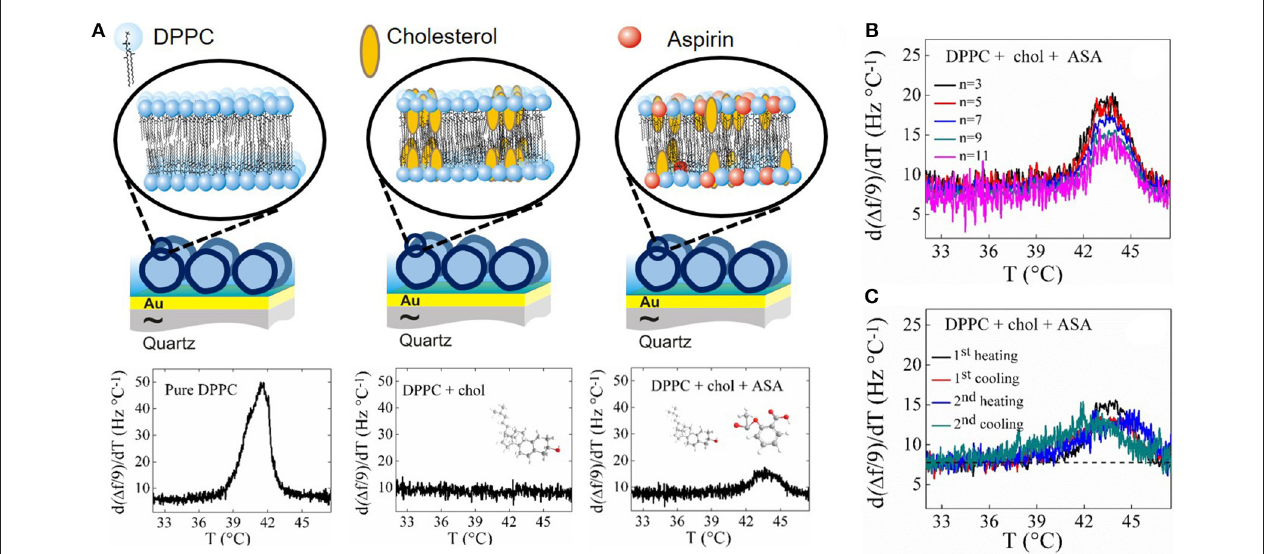
FIGURE 2 | (A) Schematic of a SVL (not to scale) on a Au-coated quartz crystal including the temperature profiles upon the first heating run of d ( 1 f /9)/ dT and d 1 D / dT for SVLs of pure DPPC, DPPC + 32.5% cholesterol and DPPC + 32.5% cholesterol with 6mM aspirin. (B) Overtone dependence of d ( 1 f /n)/ dT for DPPC + 32.5% cholesterol with 6mM aspirin SVL at the phase transition. (C) d ( 1 f /n)/ dT response upon successive heating and cooling runs for SVL of DPPC + 32.5% cholesterol with 6mM aspirin.